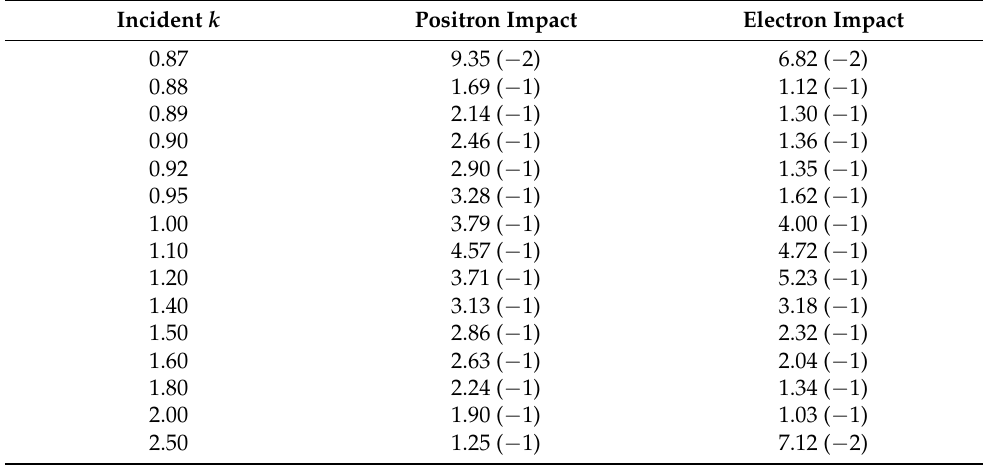
Table 5. Comparison of the positron and electron impact excitation of the sum of the n = 2 to 6 states of the atomic hydrogen.